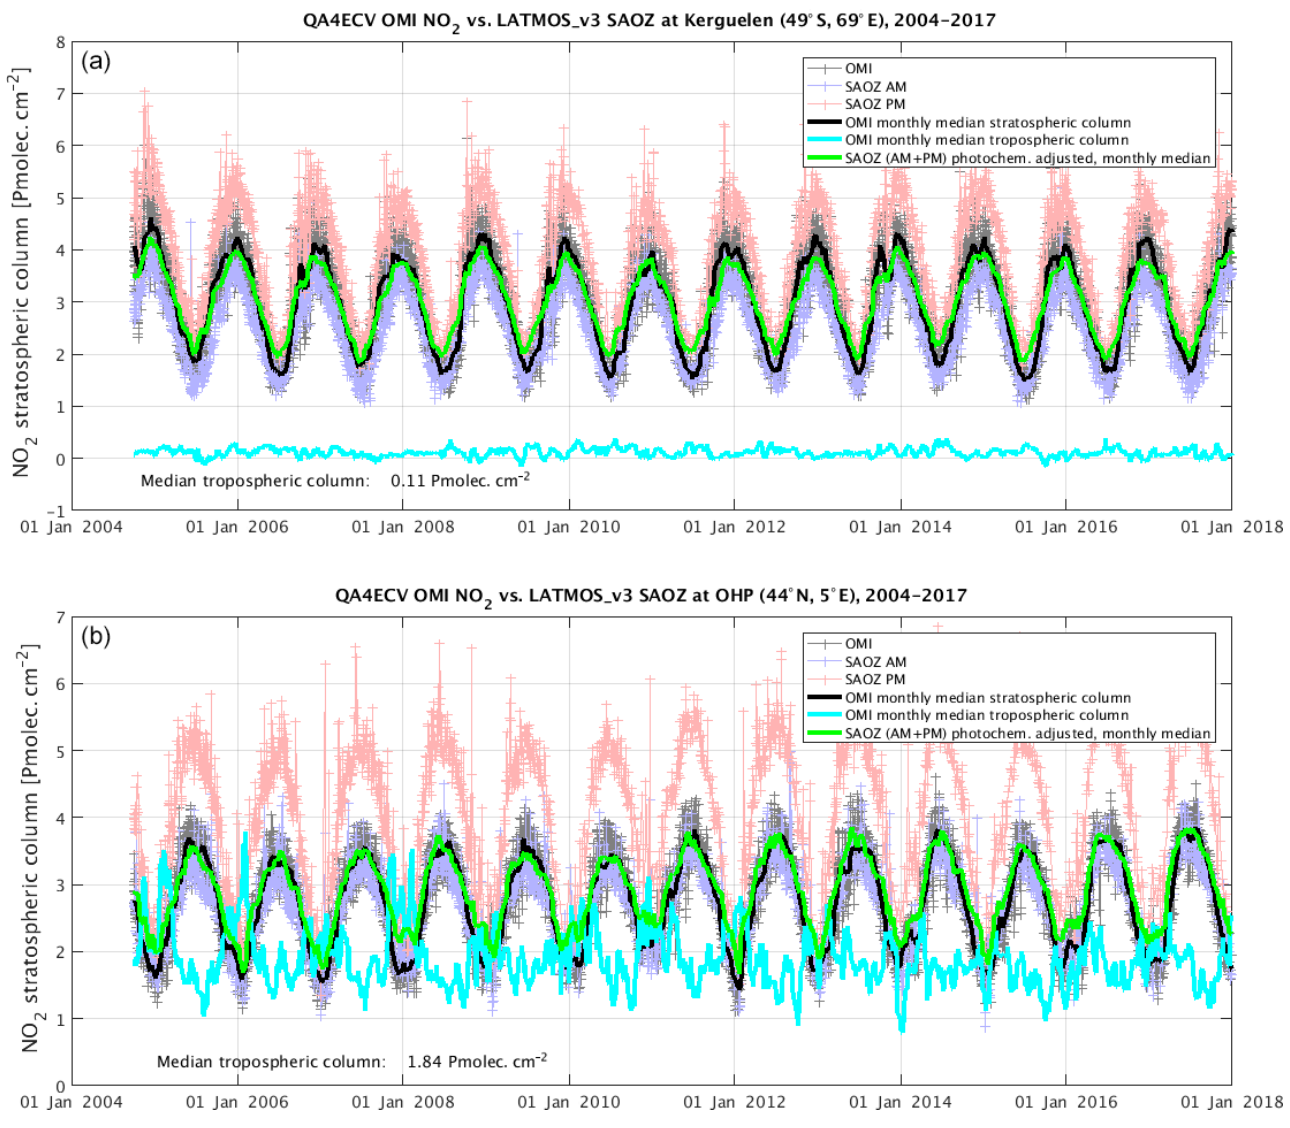
Figure 4. (a) Time series of OMI and SAOZ stratospheric NO 2 above the Kerguelen NDACC station in the Indian Ocean, which is typical of clean background conditions. Panel (b) is similar to (a) but for the Observatoire de Haute-Provence (OHP), which shows more significant tropospheric columns in winter due to anthropogenic